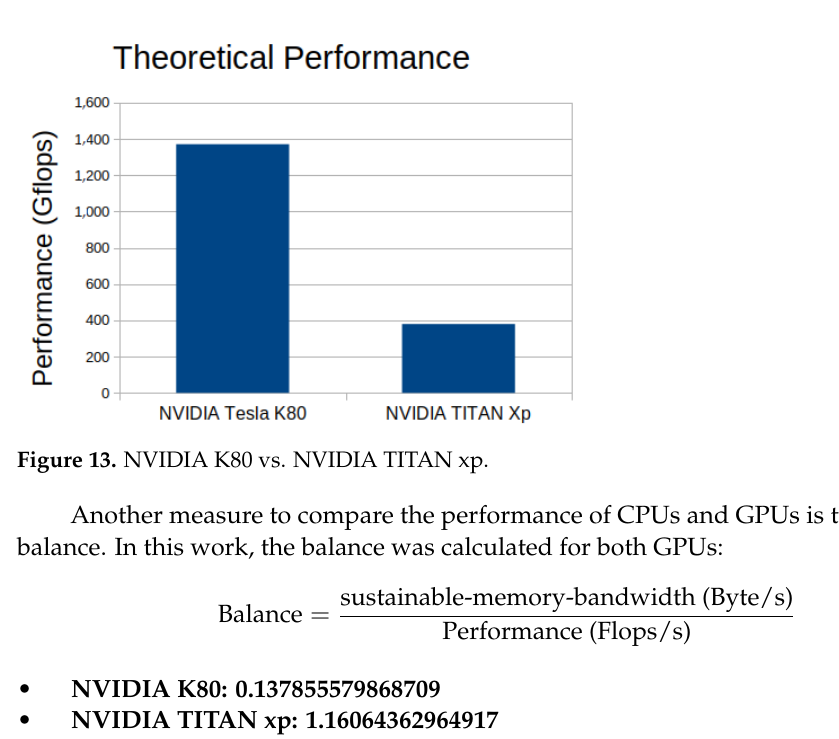
Figure 12. NVIDIA K80 (2014) vs. NVIDIA TITAN XP (2017).